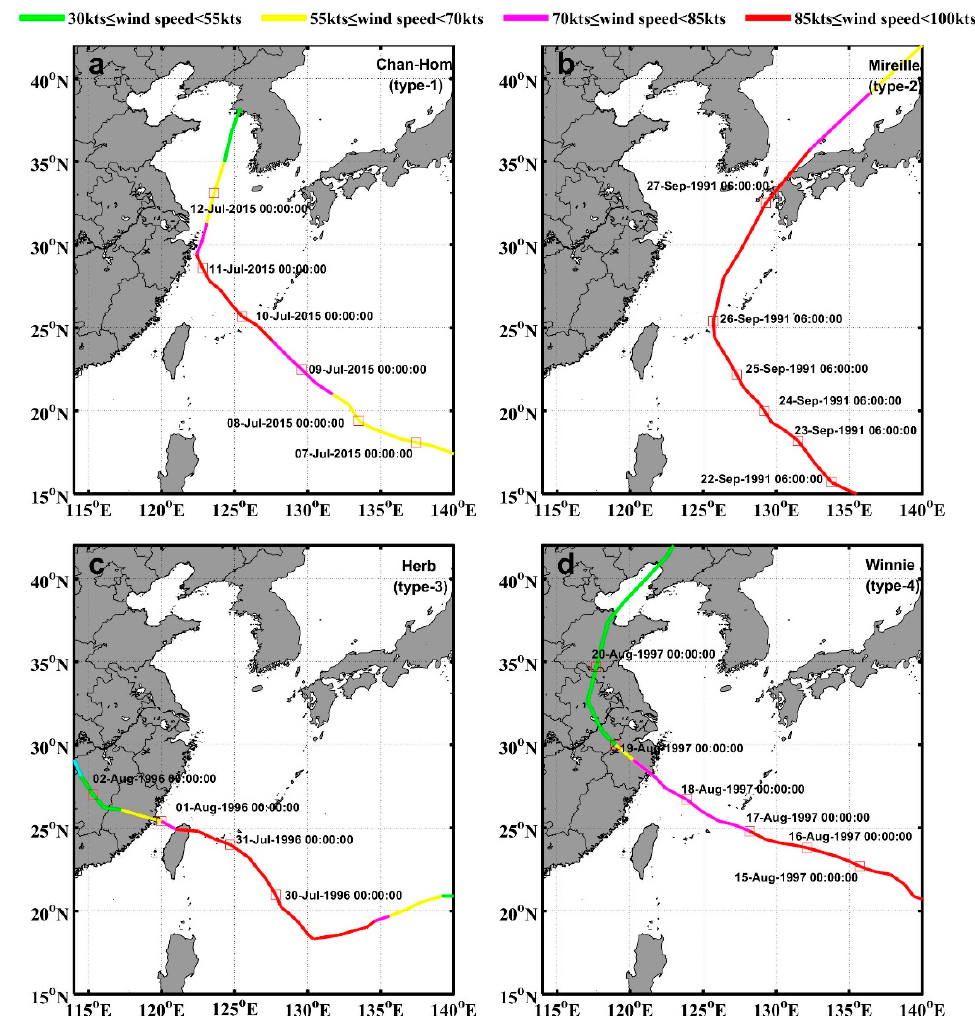
Figure 1. The path of tropical cyclone for each type: ( a ) Chan-hom (type 1), ( b ) Mireille (type 2), ( c ) Herb (type 3), and ( d ) Winnie (type 4).